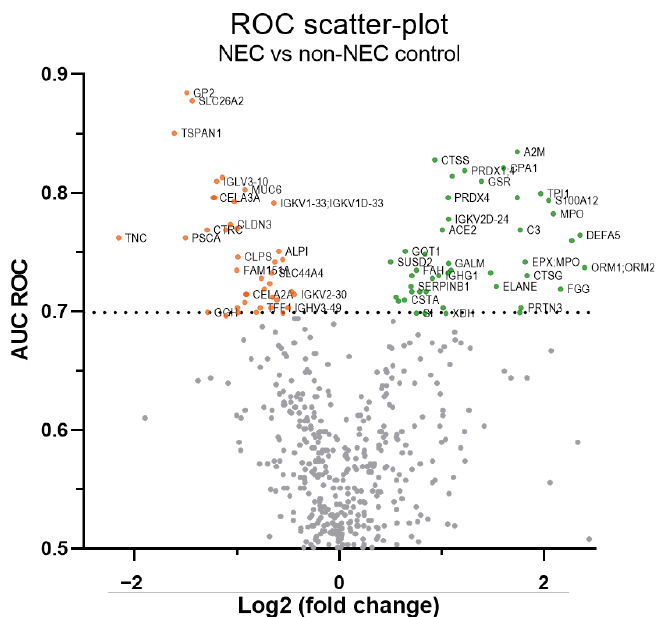
Figure 3. ROC scatterplot summarizing differentially abundant proteins in NEC stools. “Volcano-type” ROC scatter-plot of 489 proteins with ≥ 38 quantified values. On the plot, the x-axis represents the log2 fold change ratio of the mean protein levels of NEC vs. non-NEC control samples, the y-axis is the area under the curve (AUC) of the receiver operating characteristic (ROC) curve and the orange and green dots show down- and up-regulated protein levels passing the 0.7 AUC threshold (dashed line), respectively. For more clarity, gene symbols are used on the plot (see Supplementary Table S1 for corresponding protein name). Some labels have been skipped.